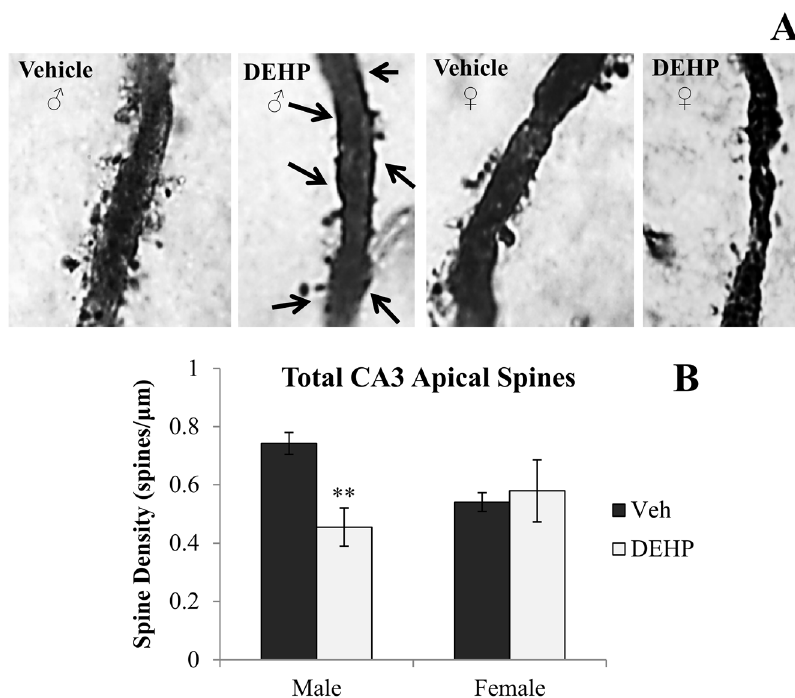
Figure 1. Spine density on apical dendrites of dorsal CA3 hippocampal neurons. (A) Representative photomicrographs of spine density on second order apical dendritic branches of CA3 neurons (100x). Quantification of the total number of basal dendritic spines per m m (B) in male and female rats exposed to di(2-ethylhexyl) phthalate (DEHP) compared to controls (Veh). Male rats exposed to DEHP showed a significant reduction in spine density on CA3 apical dendrites compared to male controls. Arrows in the DEHP-male image show regions of reduced dendritic spine density. There was no significant effect of DEHP treatment on CA3 apical spine density in female rats compared to controls. Error bars represent standard error of the mean. **= p , 0.01.